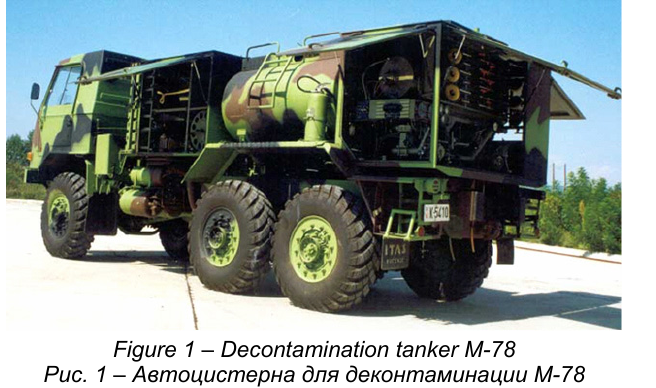
Figure 1 – Decontamination tanker M-78 Рис . 1 – Автоцистерна для деконтаминации М